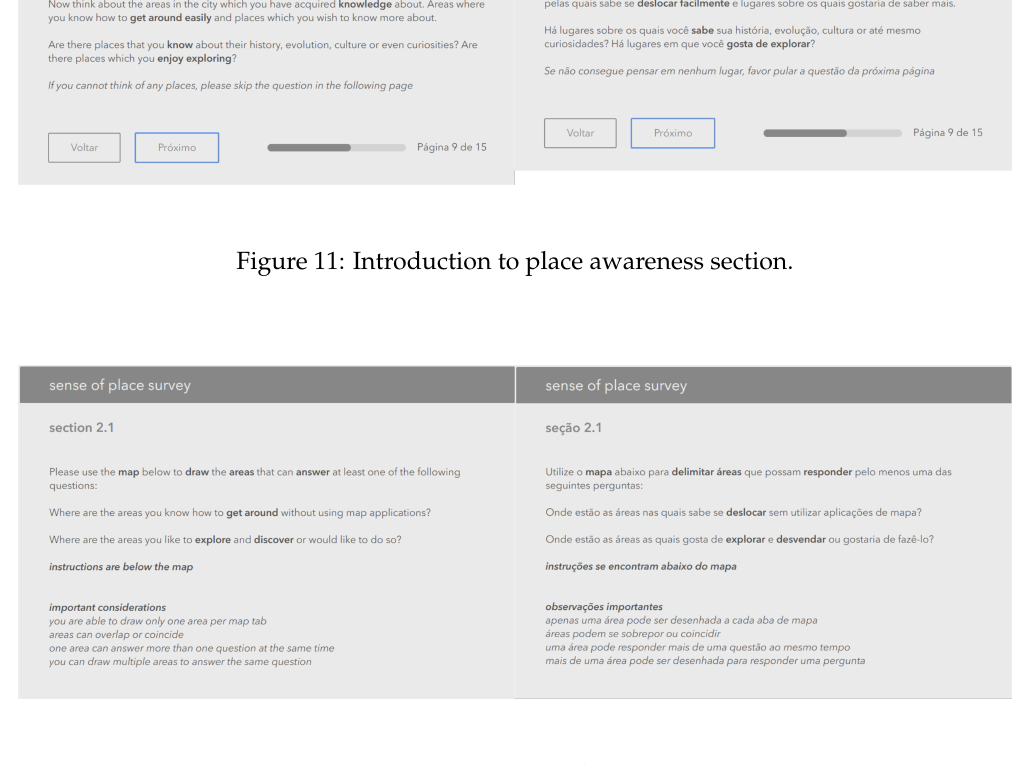
Figure 12: Map-based question for place